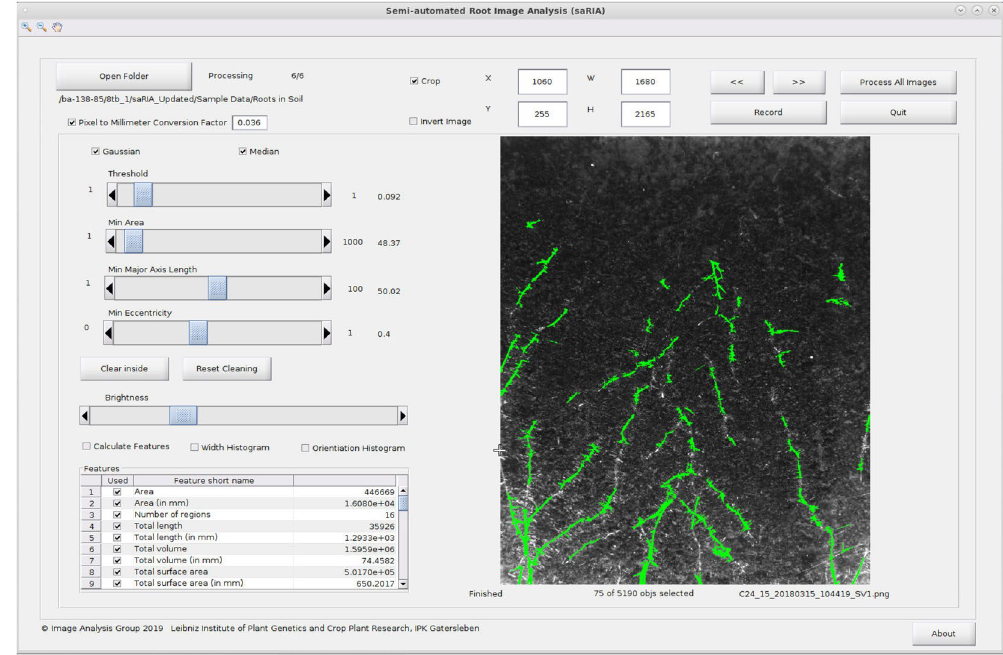
Figure 9. The graphical user interface of saRIA. Green colored pixels indicate segmented root regions of the soil-root image.